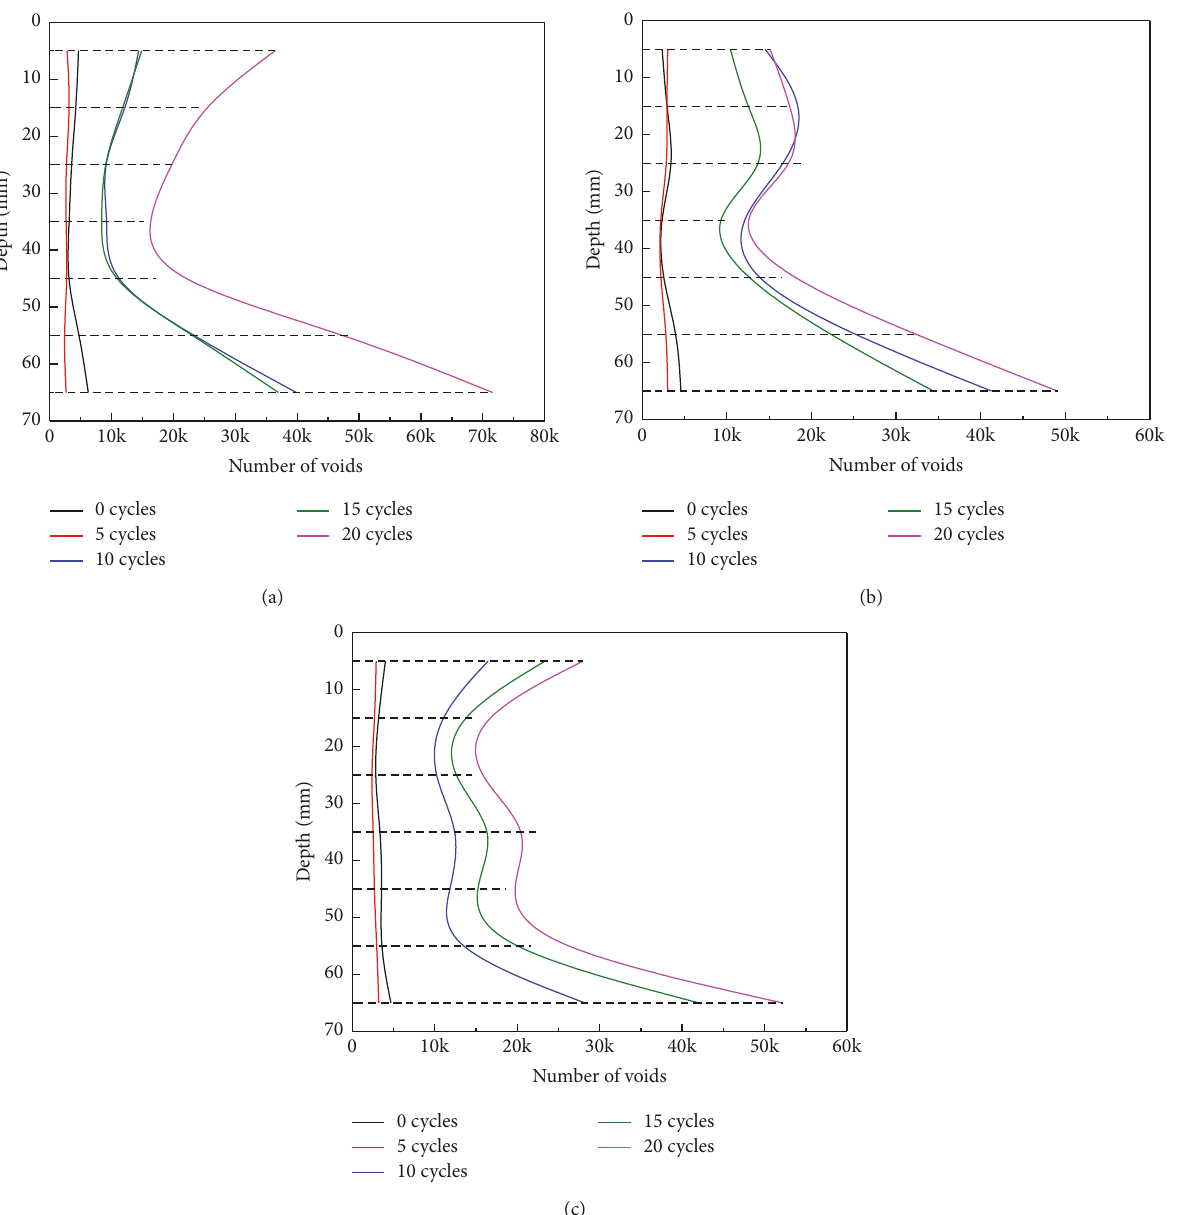
Figure 10: Void number distributions of different samples after 90d of curing: (a) cement content = 4.0%; (b) cement content = 4.5%; (c) cement content =